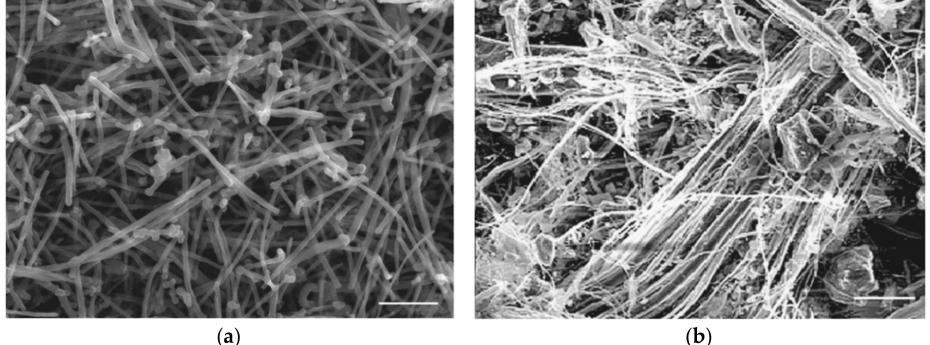
Figure 1. ( a ) Scanning electron microscopy (SEM) image of MWCNTs. Scale bar, 2 µ m. ( b ) SEM image of asbestos (chrysotile). Scale bar, 20 µ m. Reproduced with permission from [10]. Elsevier,